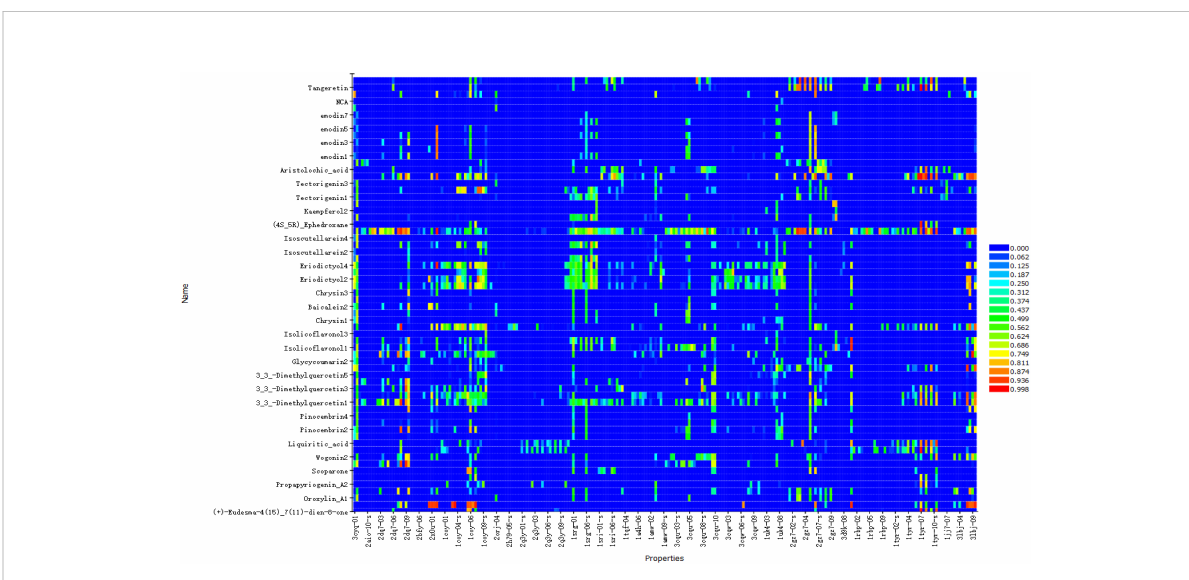
FIGURE 2 Reverse fi nding target results of QFPD. The horizontal axis represents the pharmacophore models, and the longitudinal axis represents the active components. Due to the limited size of the picture, we only show more promising pharmacophore models and active